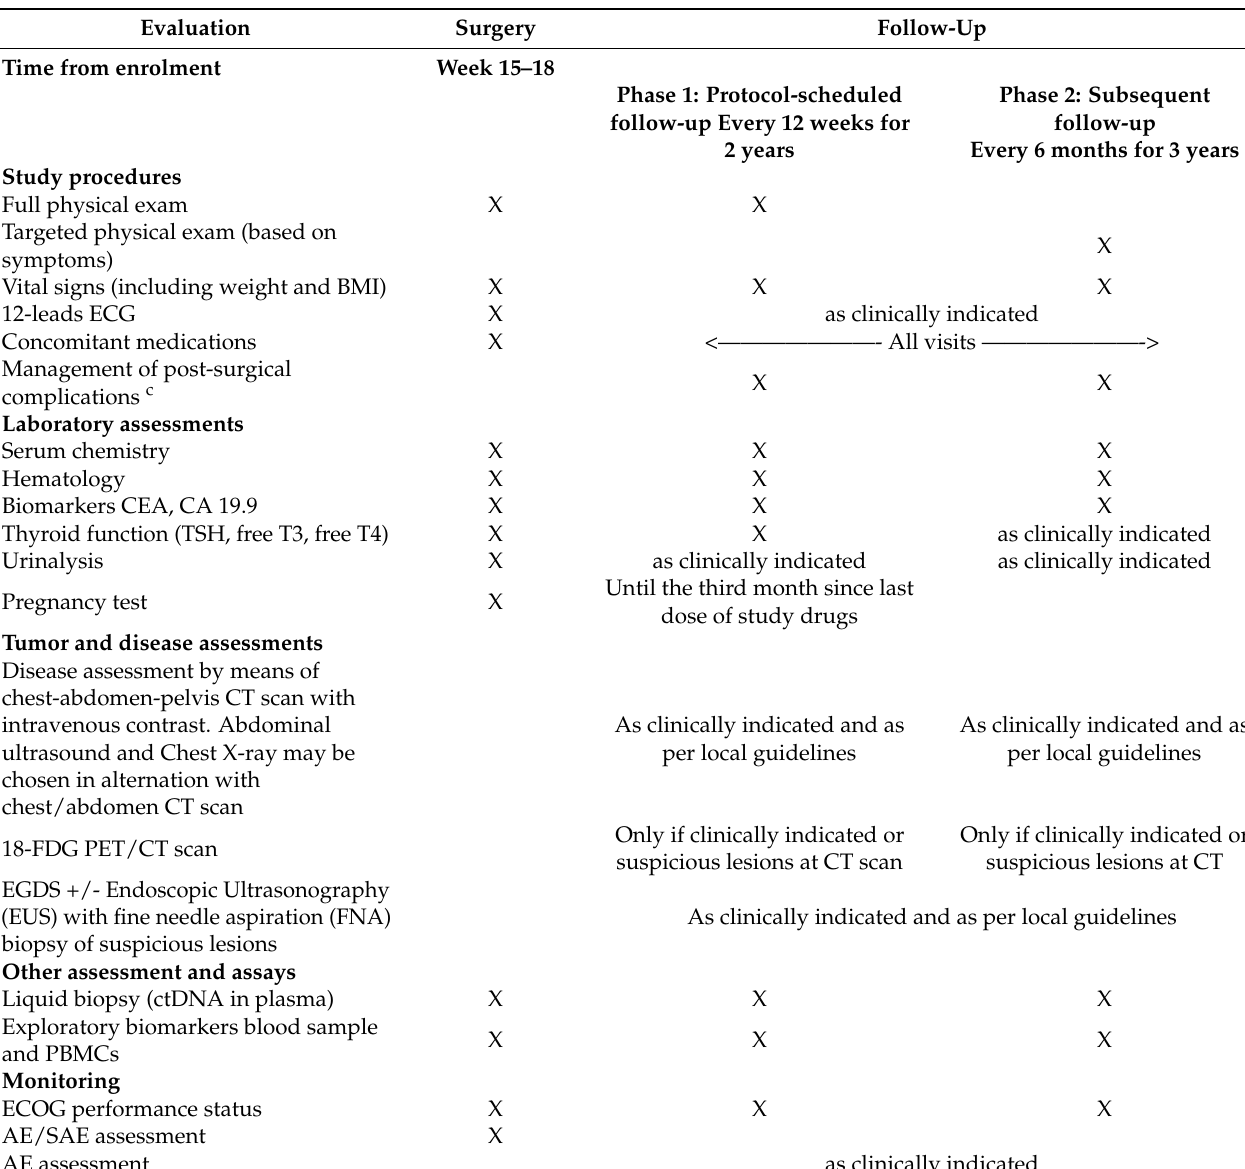
Table 2. Schedule of assessments for Cohort 1 and for Cohort 2 patients in absence of clinical complete